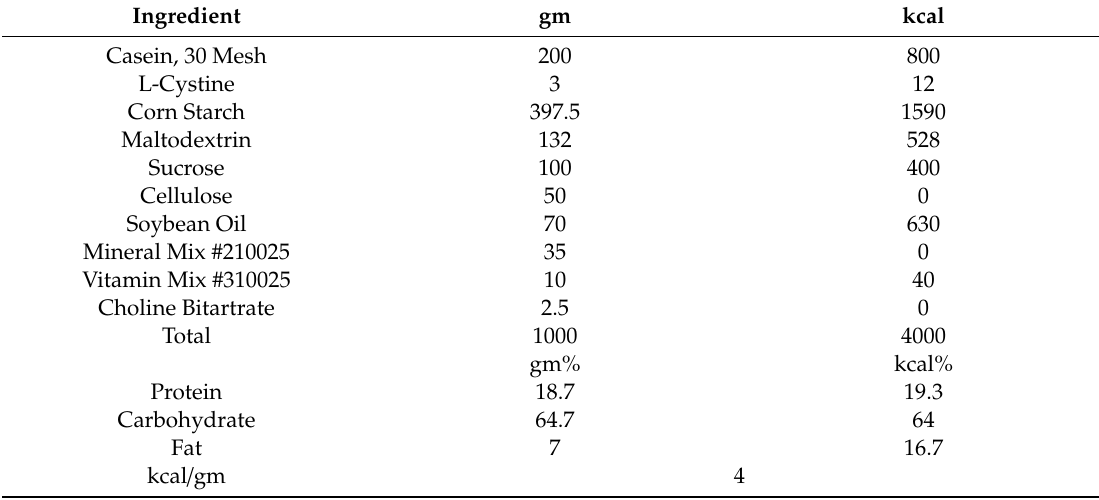
Table 1. The composition of the control diet (AIN